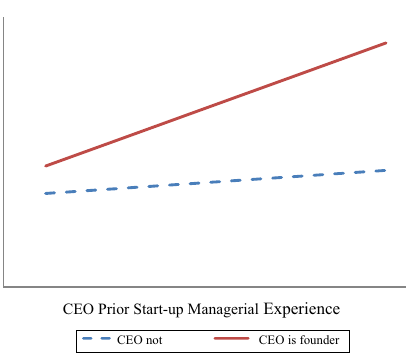
Figure 2. Interaction